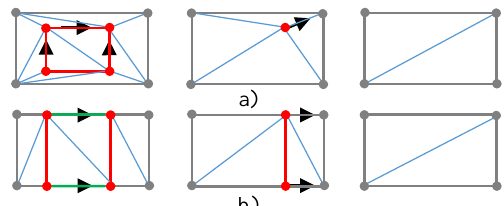
Figure 4. Two sequences of operations that finalize the triangle mesh after a Push Plane